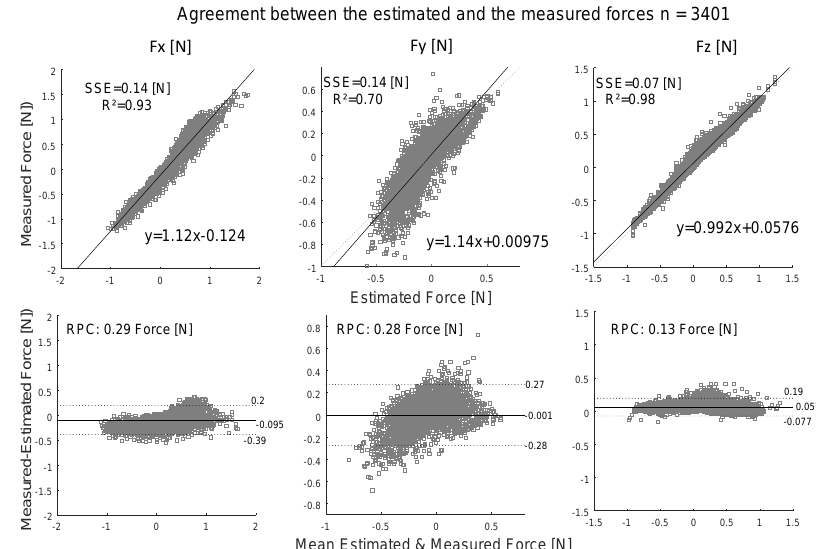
Figure 8. Comparison of the experimental and computed forces (Fx, Fy, Fz) throughout the 34 s experiment (number of data points n = 3401) show strong coherence and small discrepancy between the estimated and measured